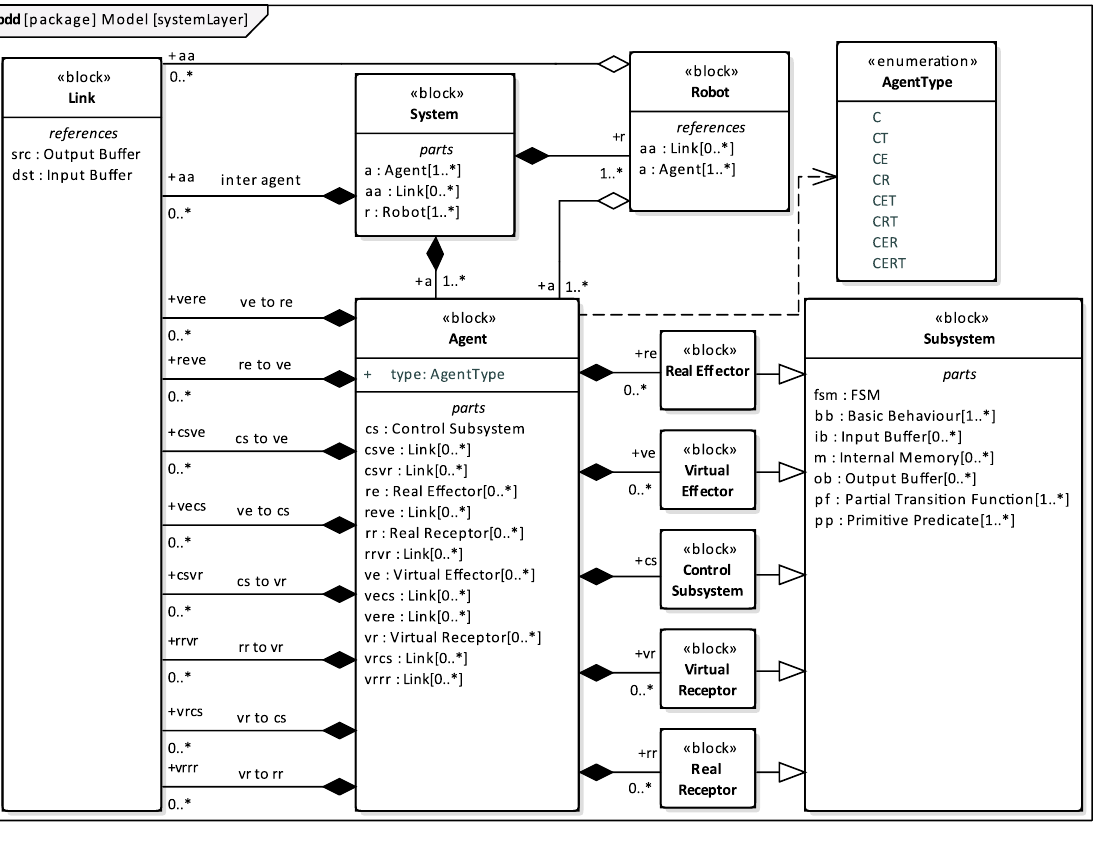
Figure 2. System and its